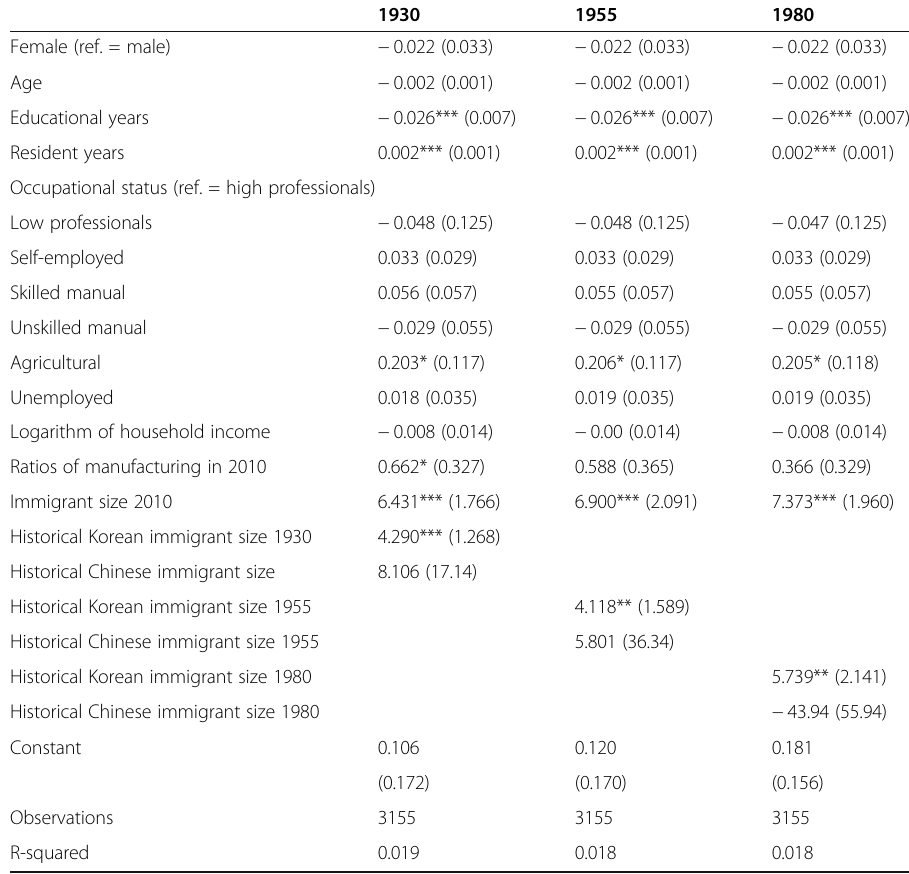
Table 5 OLS regression models of Japanese residents ’ xenophobia 1930 1955 1980 Female (ref. =